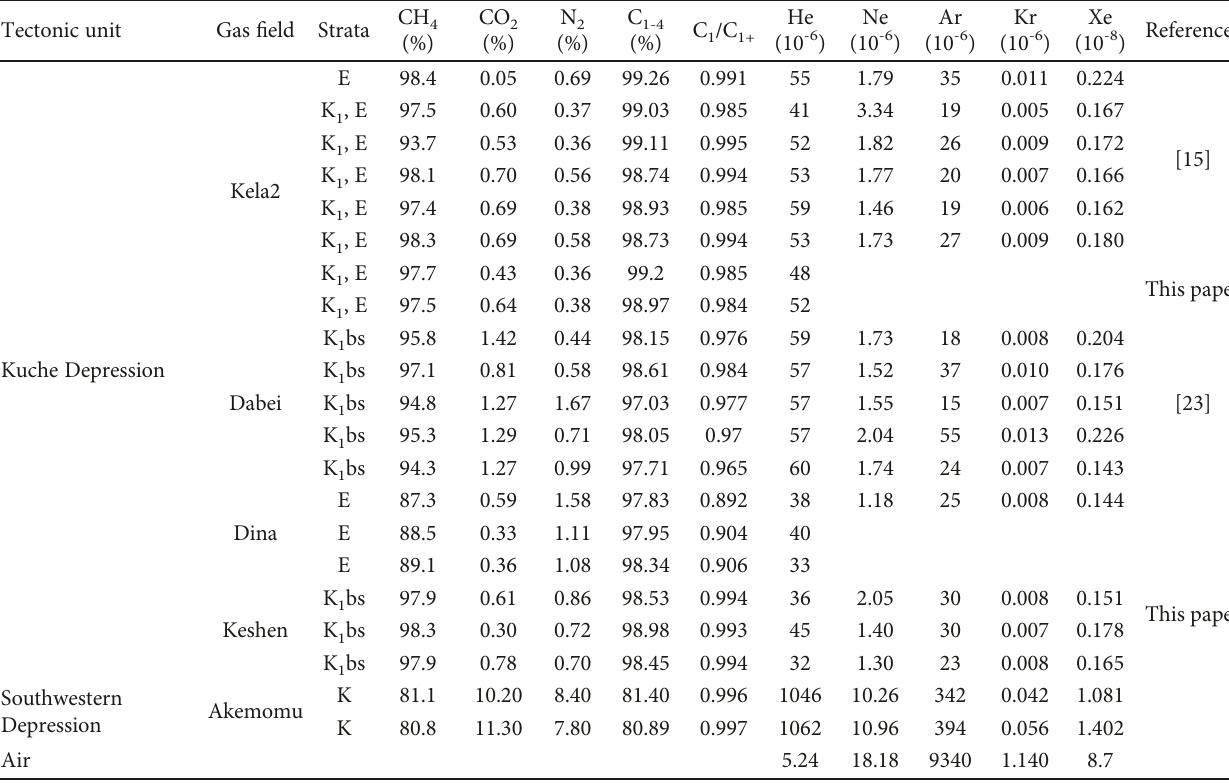
Figure 3: Broken line chart of helium, neon, argon, krypton, and xenon abundances in some gas fi elds from the Kuche and Southwestern Depressions, Tarim Table 1: Molecular composition of hydrocarbon, nonhydrocarbon, and rare gases in some gas fi elds from the Kuche and Southwestern Depressions, Tarim Basin.